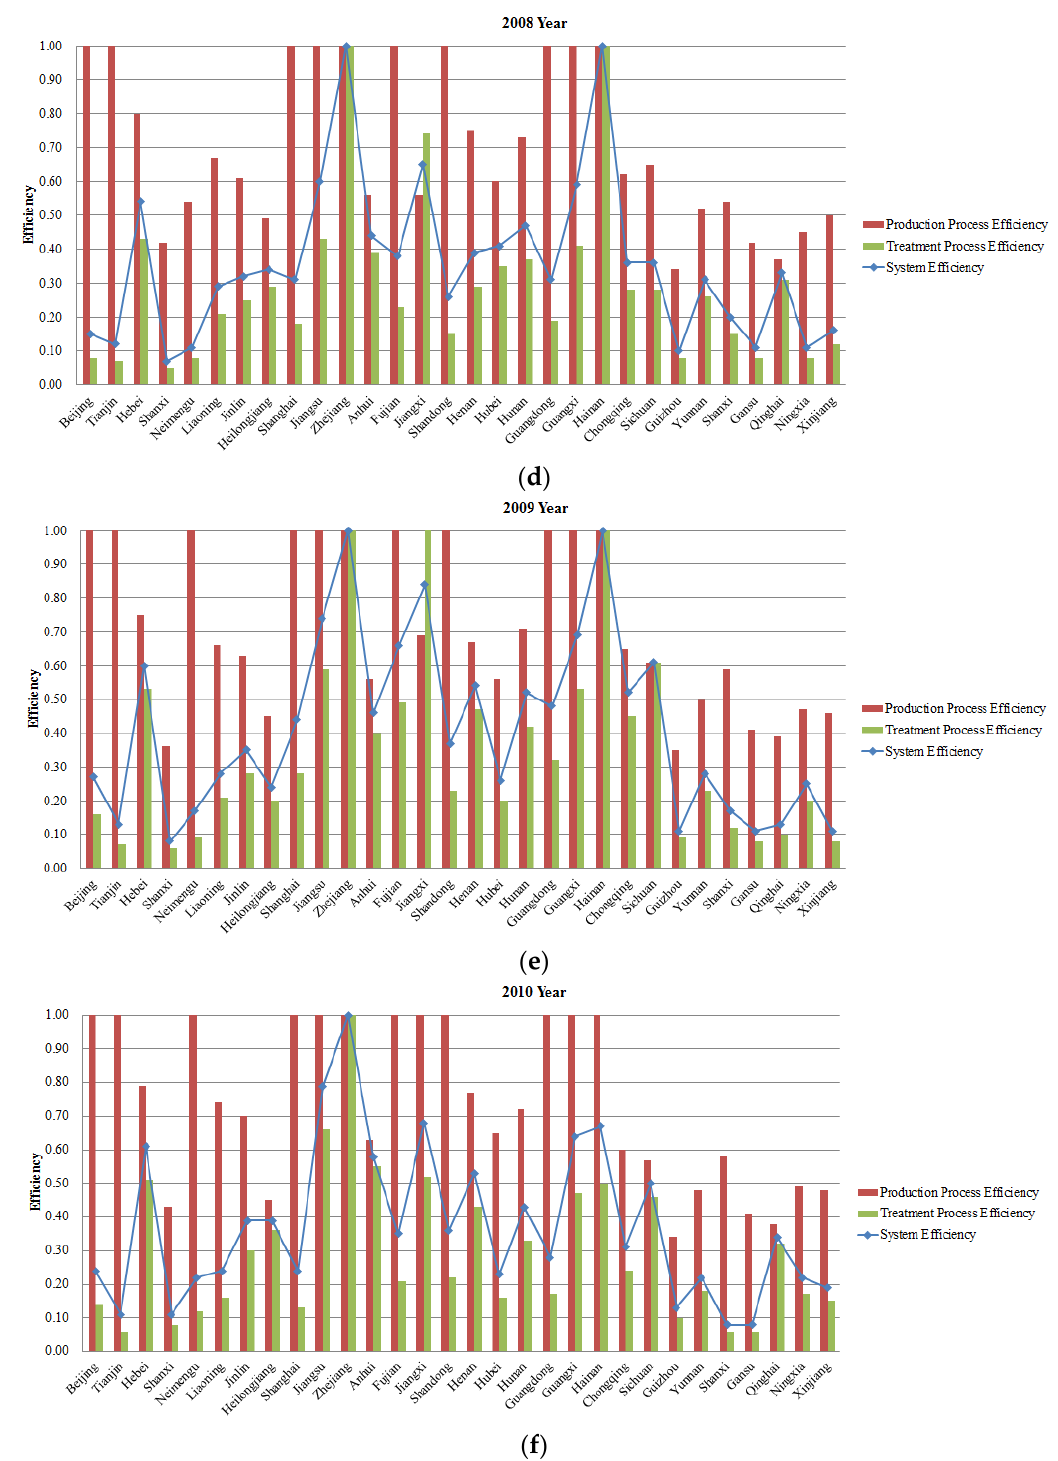
Figure 5. ( a ) System and process efficiencies in 2005. ( b ) System and process efficiencies in 2006. ( c ) System and process efficiencies in 2007. ( d ) System and process efficiencies in 2008. ( e ) System and process efficiencies in 2009. ( f ) System and process efficiencies in 2010.